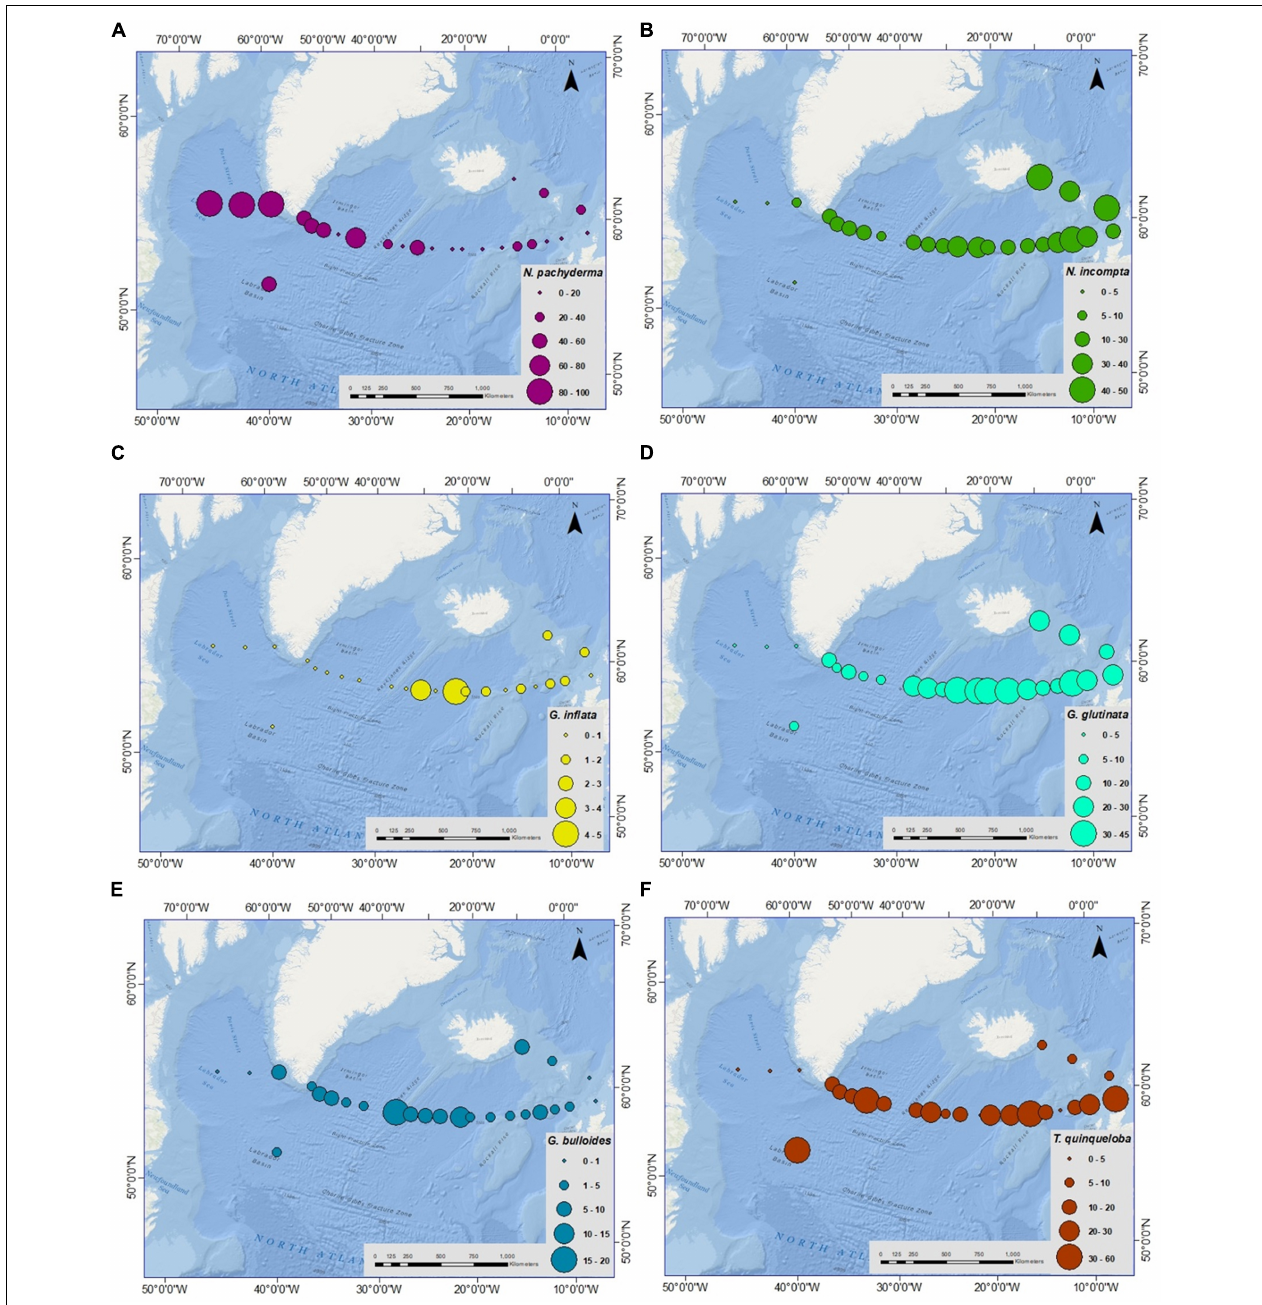
FIGURE 4 | Spatial variation in relative abundance (%) of planktic foraminiferal species (A) Neogloboquadrina pachyderma ( N . pachyderma ), (B) Neogloboquadrina incompta ( N . incompta ), (C) Globorotalia inflata ( G . inflata ), (D) Globigerinita glutinata ( G . glutinata ), (E) Globigerina bulloides ( G . bulloides ), (F) Turborotalita quinqueloba ( T . quinqueloba ) from Labrador Sea to Faroe-Shetland channel. Please note the percentage range for each species is